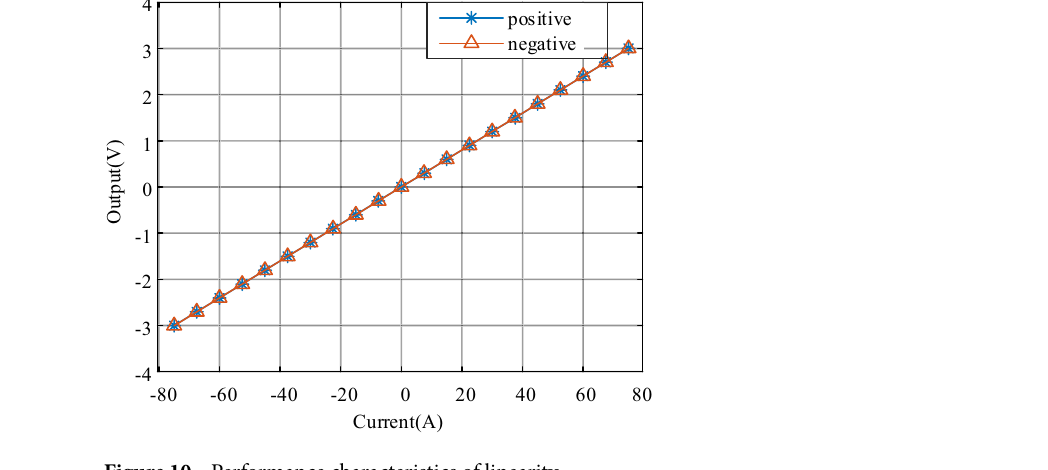
Figure 10. Performance characteristics of linearity.